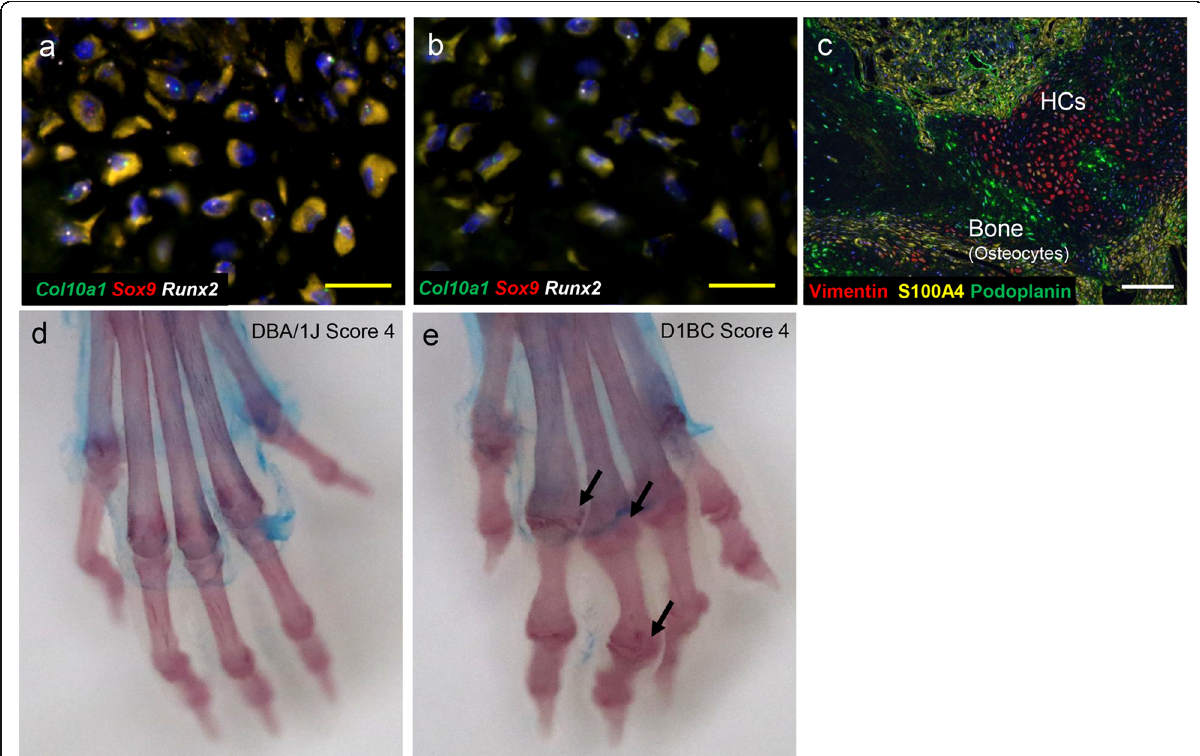
Fig. 5 Hypertrophic chondrocytes express Runx2 , Sox9 , and Col10a1. In situ hybridization was performed [16]. a, b Sox9 (red), Runx2 (white), and Col10a1 (green) mRNA signals in hypertrophic chondrocytes ( a ) and osteocytes ( b ) in bColII-D1BC inflamed joints. c In pannus, OCs in bone, HCs, and synovial fibroblasts express podoplanin (green), vimentin (red), and S100A4 (yellow), respectively. Scale bar = 20 μ m (yellow) and 50 μ m (white). d, e Joint space narrowing, erosion, and osteoporosis in bColII-D1BC mice. D1BC and DBA/1J mice were injected with a low-dose of bColII to induce joint inflammation. Whole-mount bone and cartilage staining with alizarin red S and alcian blue, for bone (red) and cartilage (blue), respectively. All mouse limbs at 1 year after the first immunization. No ankylosis in CIA-induced DBA/1J mouse ( d ). Note, the complete destruction of all joints (ankylosis, allow) and shortening of the phalanges in bColII-D1BC mouse joints ( e